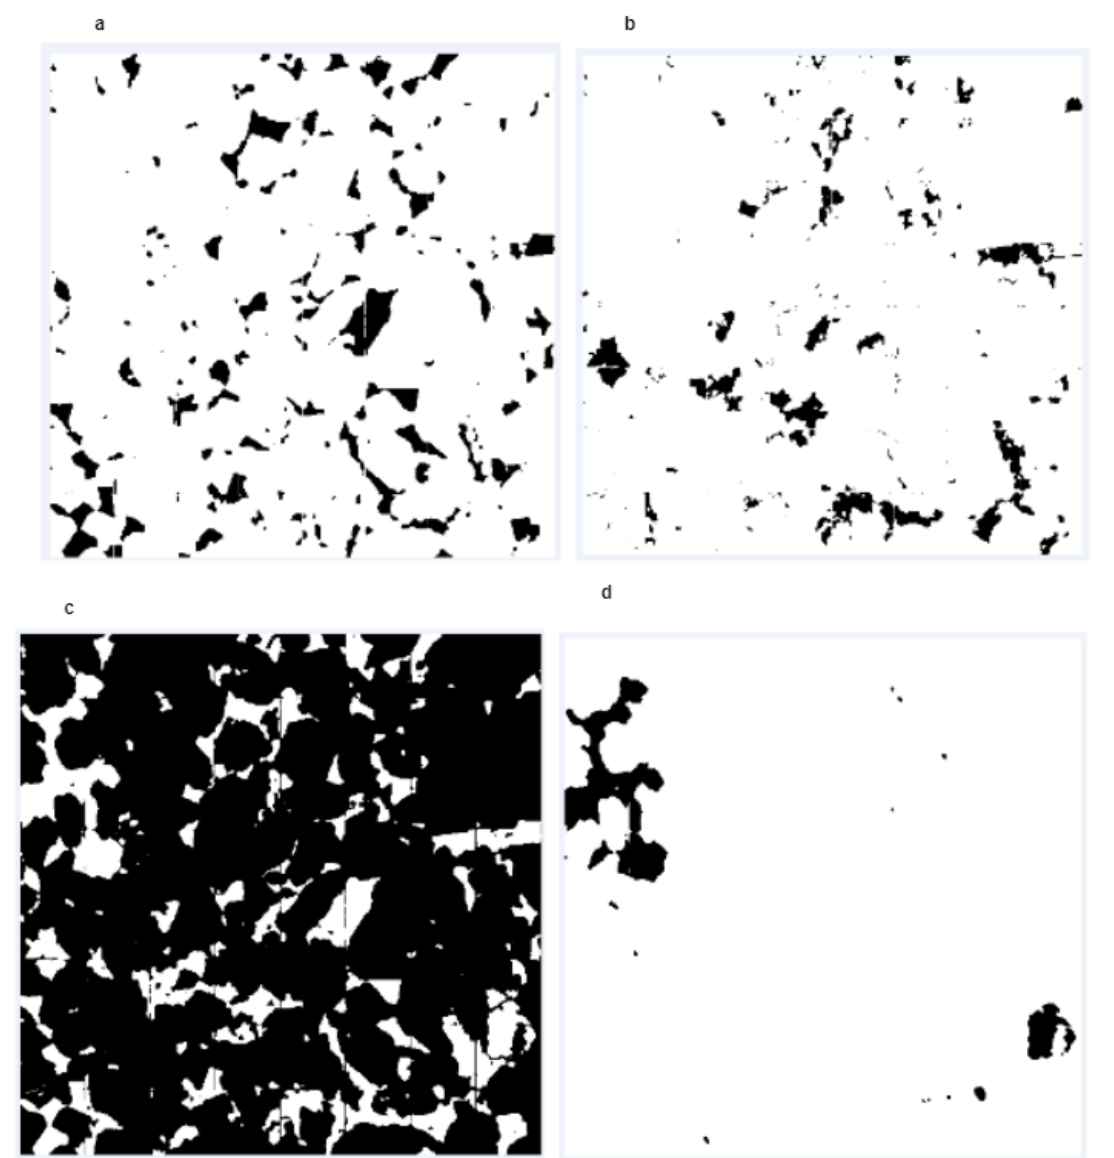
Figure 6. ( a , b ) Eight (8)-bit binary conversion of our individual segmentation (pore and mineral 1. ( c , d ) Eight (8)-bit binary conversion of our individual segmentation (mineral 2 and mineral